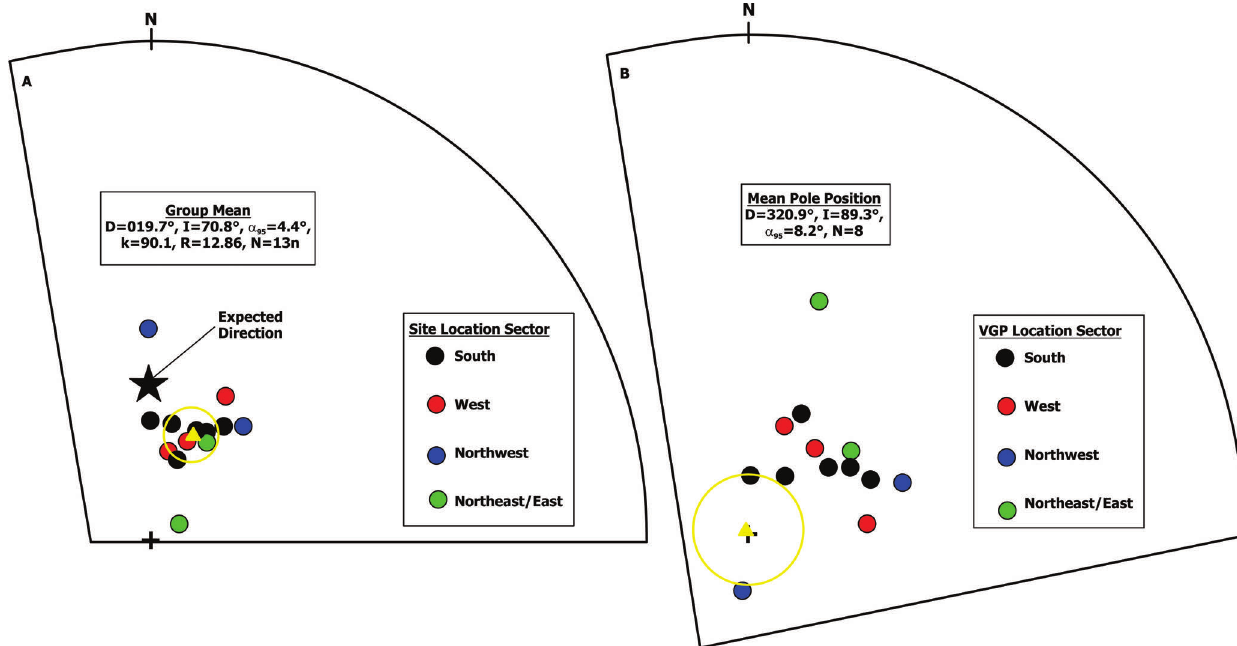
Figure 12: Paleomagnetic data from the Puy de Dôme. [A] Lower hemisphere equal area projection of site mean paleomagnetic data from the Puy de Dôme. The yellow triangle indicates the group mean result of the 13 ac- cepted sites with α 95 confidence ellipse about the group mean direction. The black star is the Quaternary ref- erence direction based on the average of multiple paleomagnetic poles (Table 2). [B] Lower hemisphere equal area projection of site mean virtual geomagnetic pole positions (VGPs). The yellow triangle with A95 confidence ellipse indicates the mean Quaternary virtual geomagnetic pole position (Table